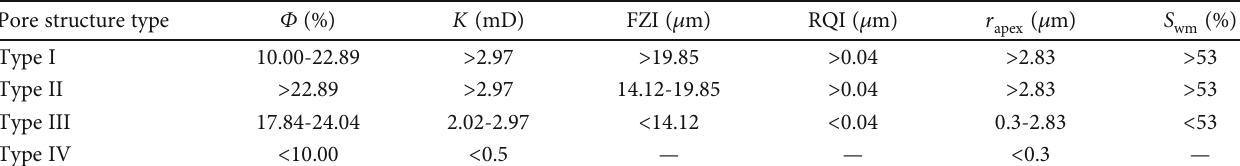
Table 4: Quantitative classi fi cation of 4 pore structure types.